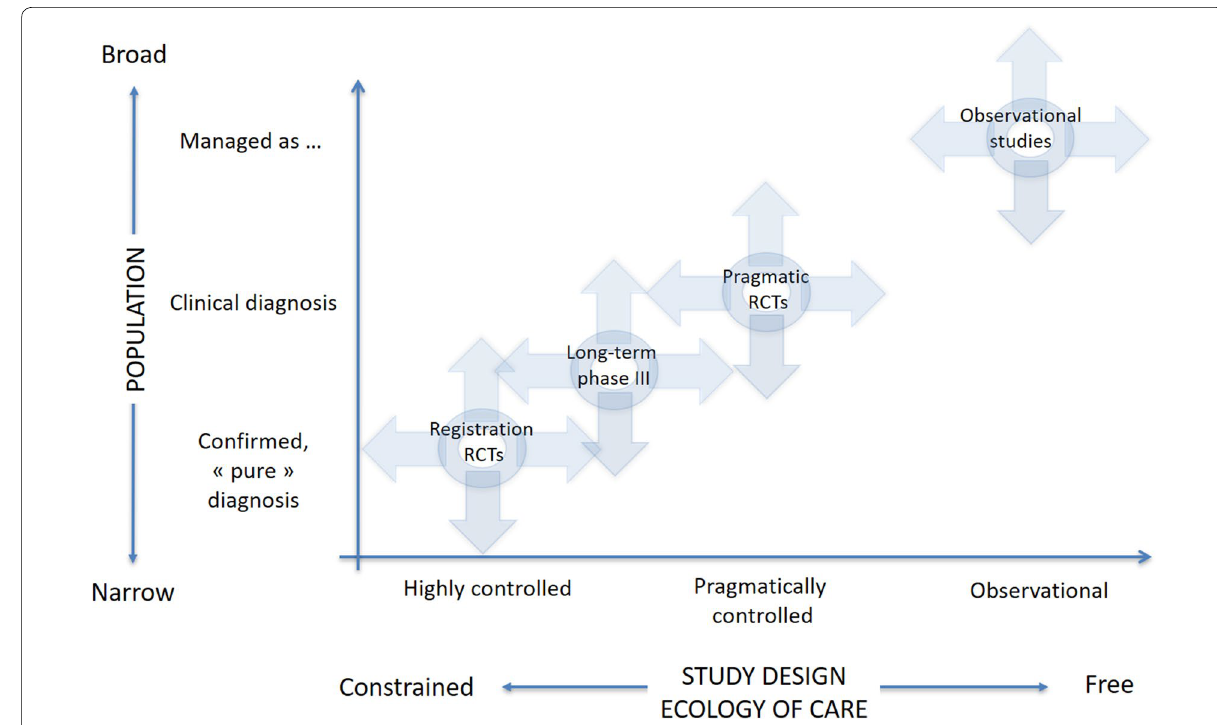
Fig. 2 REG research framework. Reproduced with permission from